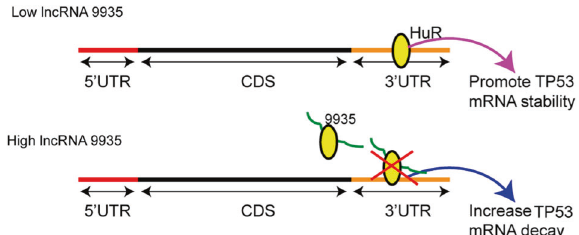
Fig. 7 Mechanism fi gure. 9935 is downregulated during septic AKI progression and its overexpression restrains the combination of HuR and 3 ′ UTR region of Tp53 , thereby lessening the p53 expression and suppressing the apoptosis of